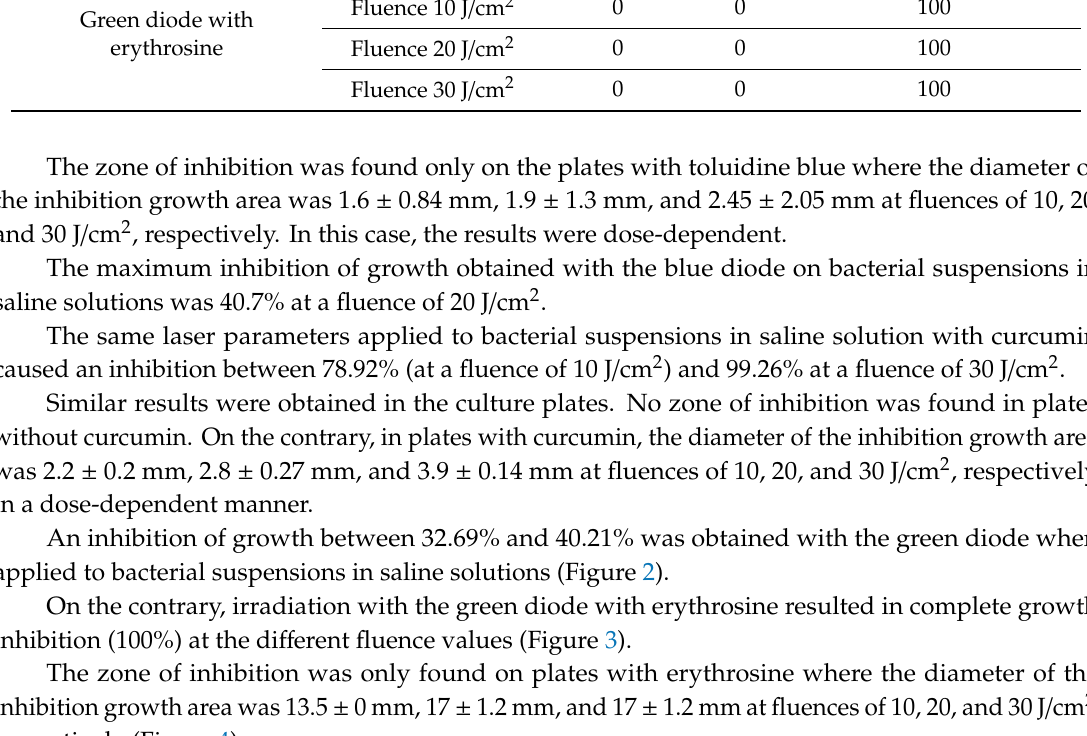
Fluence 10 J / cm 2 0 0 Fluence 20 J / cm